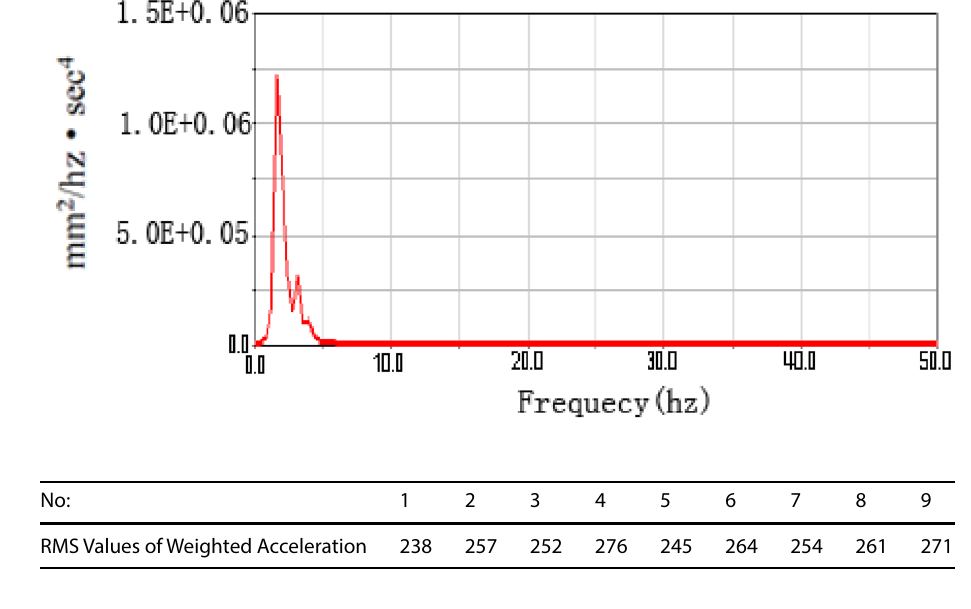
Table 4 The RMS Values of Weighted